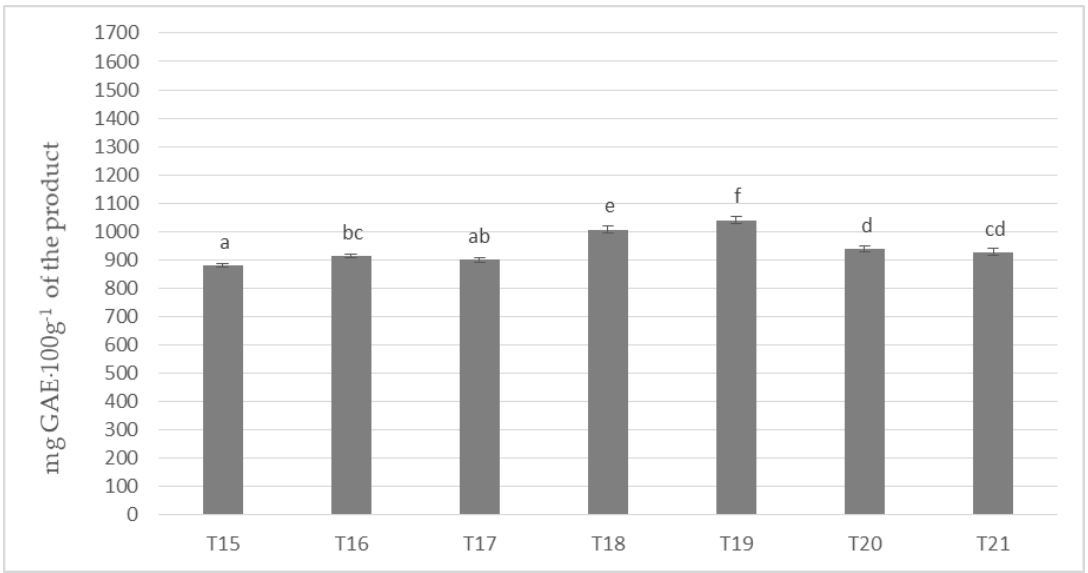
Figure 3. Polyphenols in chocolate milk masses prepared from Ghana cocoa liquor (the same letter means that there are no statistically significant differences between the analyzed products at a confidence level of α = 0.05; the abbreviations used in the graph are described in Table 3).